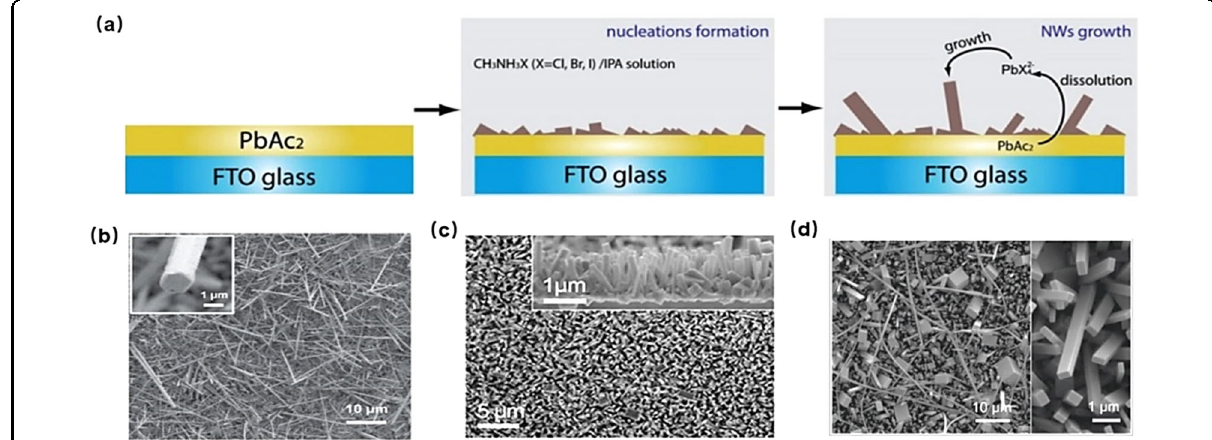
Fig. 2 Growth of 1D morphological MHP by solution-phase methods. a Schematic presentation of the growth of MAPbX 3 NWs. Reproduced with permission from ref. 42 . Copyright 2015, Nature Publishing Group. b Scanning electron microscopy (SEM) image of as-prepared FAPbI 3 NWs. Reprinted with permission from ref. 43 . Copyright 2016, American Chemical Society. c Top view of a MAPbBr 3 NR array. Reprinted with permission from ref. 44 . Copyright 2015, American Chemical Society. d SEM image of CsPbBr 3 NWs. Reprinted with permission from ref. 45 , Copyright 2016, American Chemical